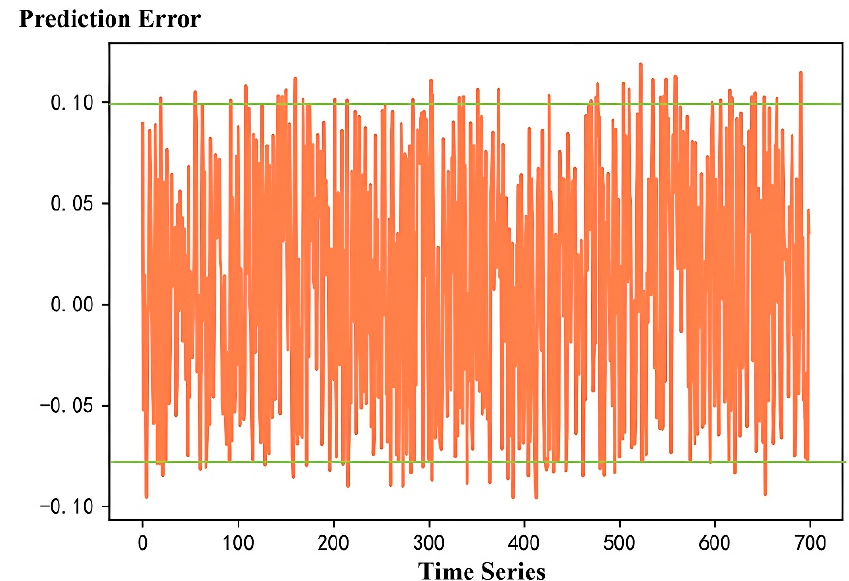
Figure 13. Errors between the predicted data and the actual data.